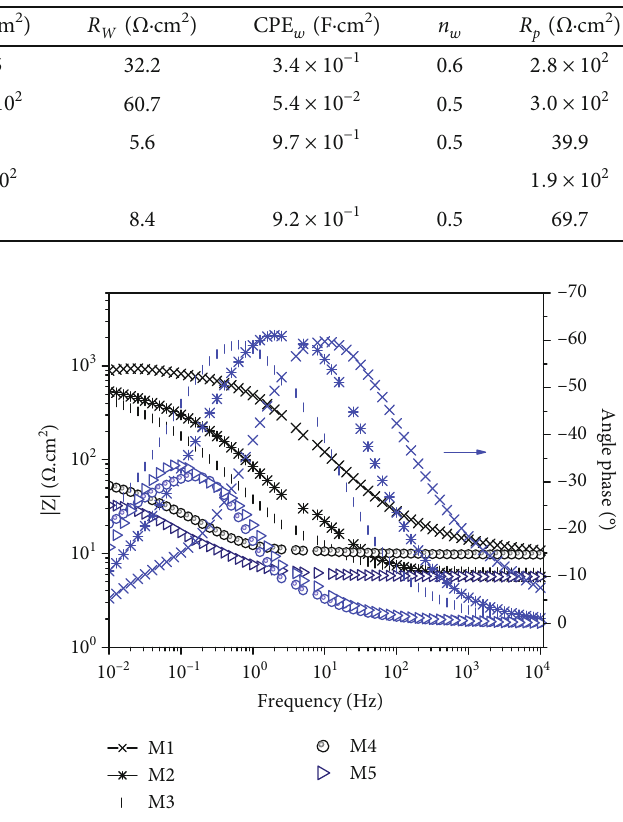
Figure 5: Modulus impedance and angle phase for aluminum- based alloy doped with Mn and Co after heat treatment at 600 ° C immersed in 3 M